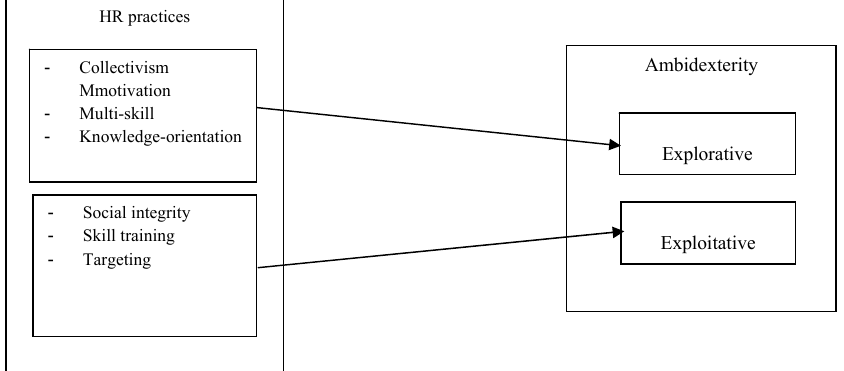
Fig. 1. Conceptual model of research based on research by Ferraris (2018)